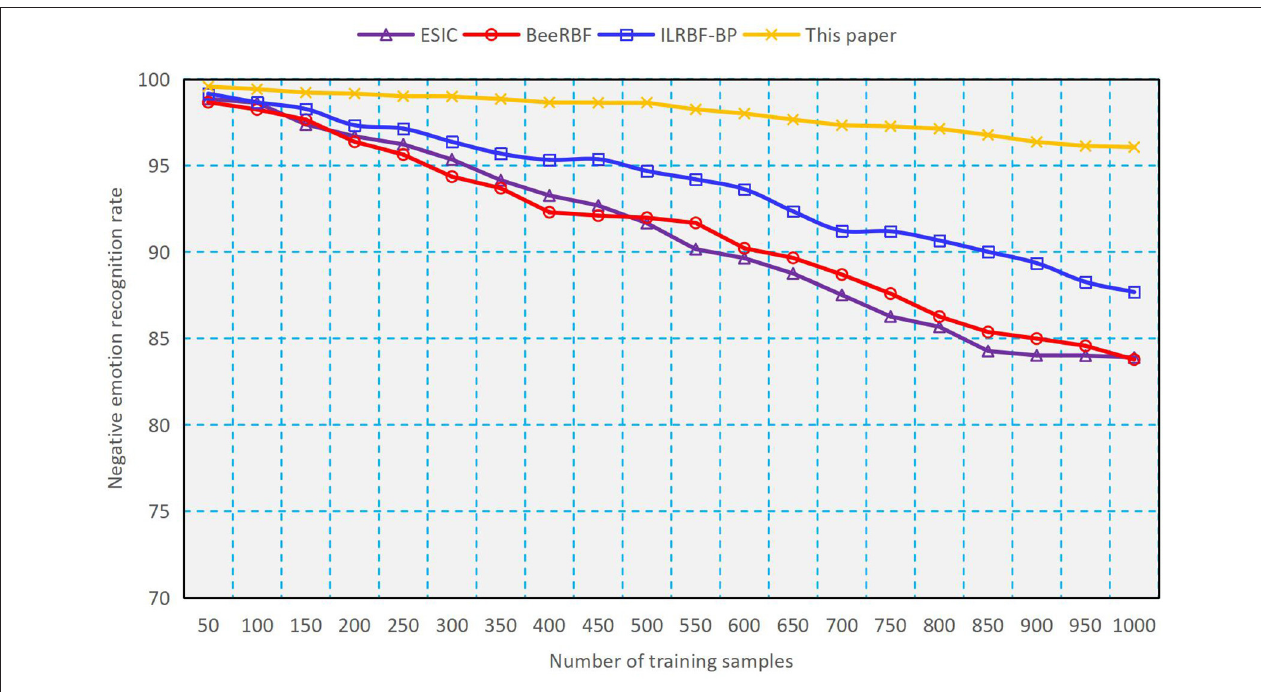
FIGURE 4 | Performance of Negative emotion recognition